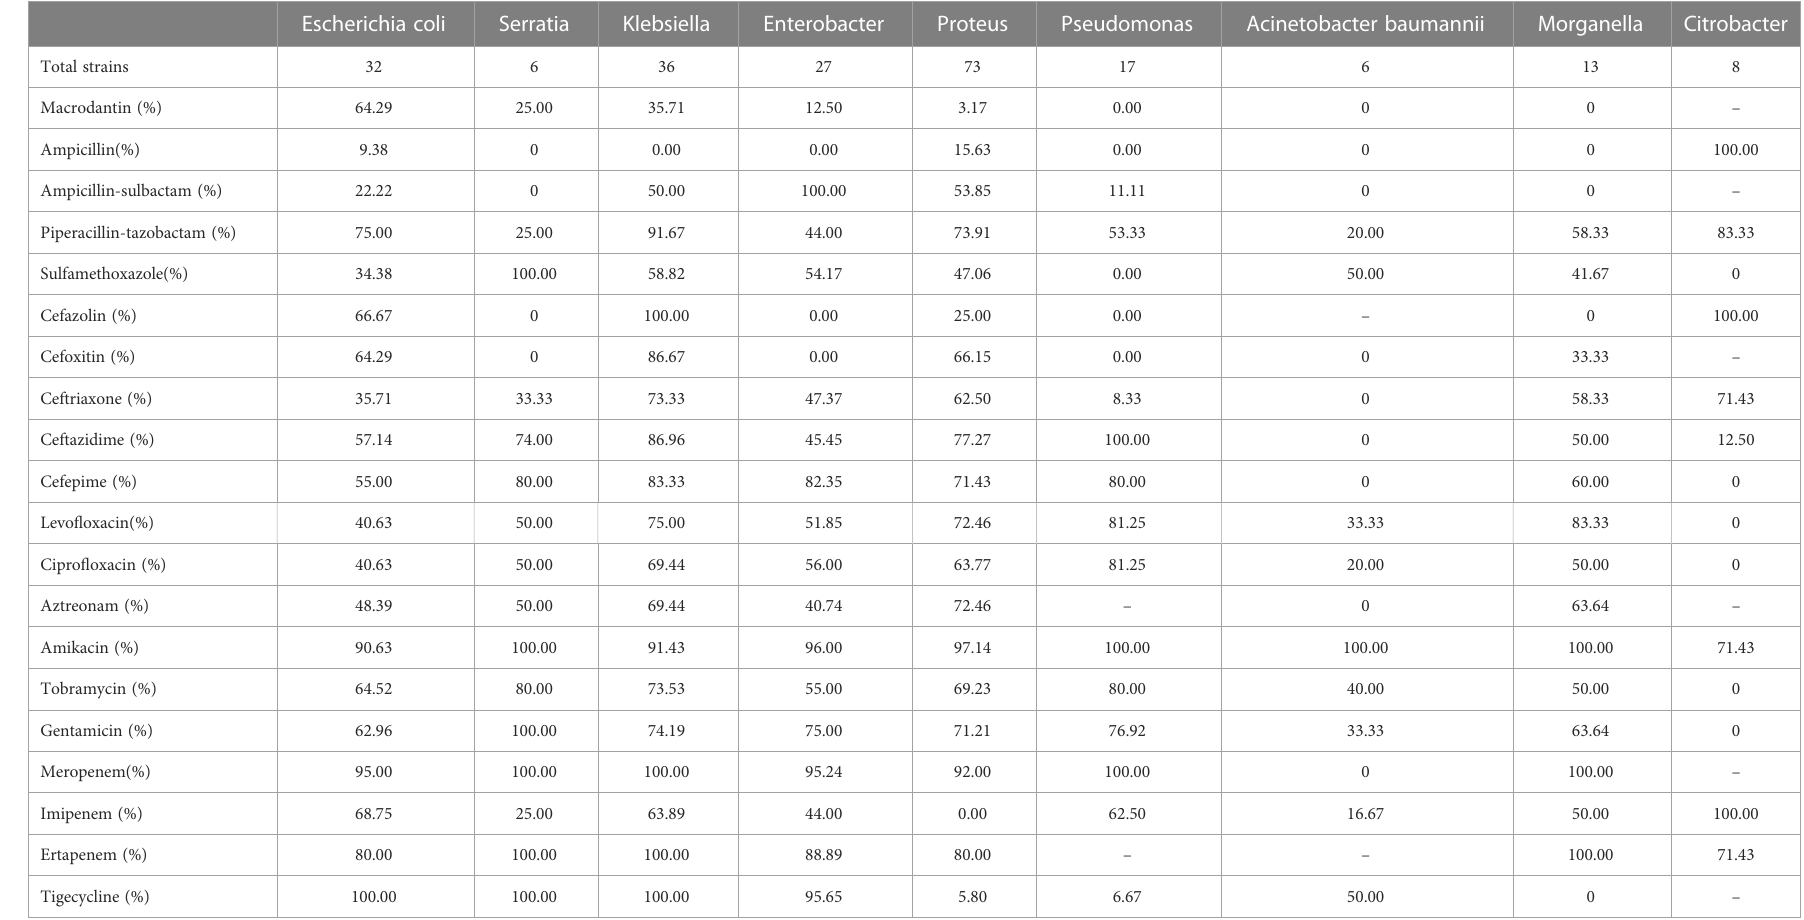
TABLE 4 The drug sensitivity results of gram-negative bacteria from diabetic foot